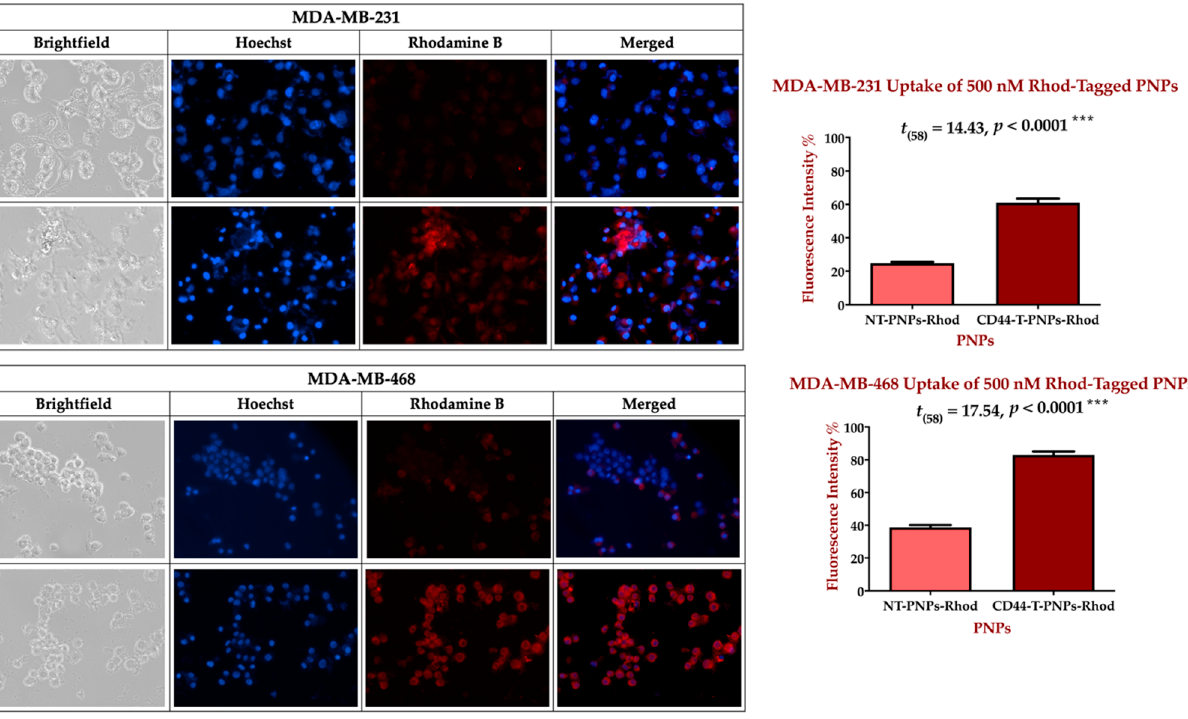
Figure 4. CD44 receptor-mediated selective delivery of CD44-T-PNPs in TNBC cell lines. MDA-MB-231 ( A ) and MDA-MB-468 ( B ) were selectively uptake CD44-T-PNPs/Rhodamine in comparison to NT-PNPs/Rhodamine after treatment with 500 nM for 1.5 h. The intensity was measured by Zen 2012 (blue edition), and significance was calculated by t -test in Prism. The data are present as a mean ± SEM. Magnification is 40×.